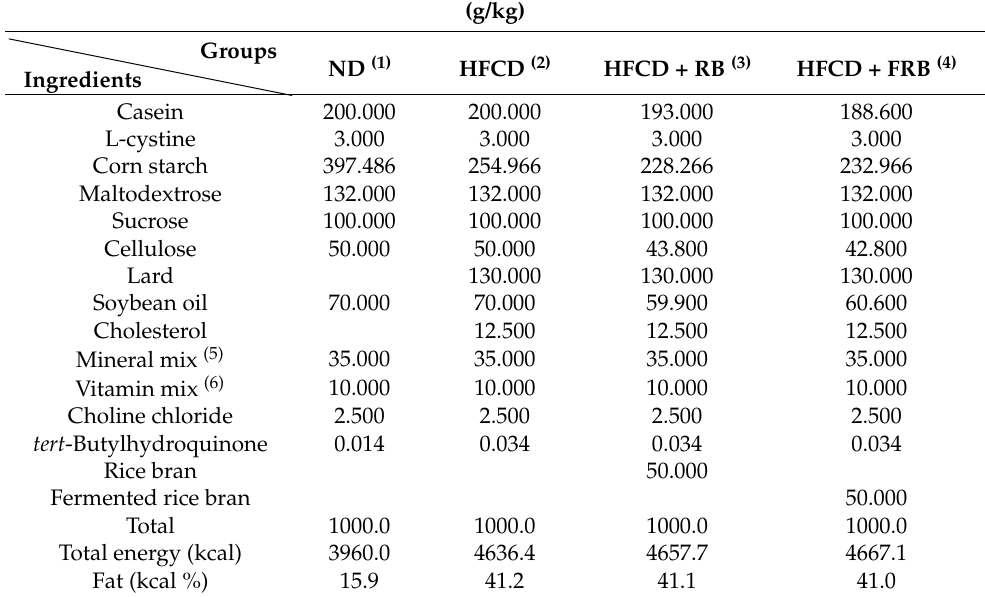
Table 1. Composition of experimental